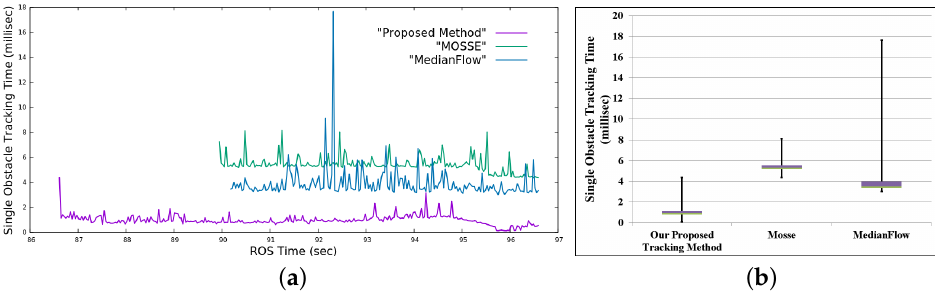
Figure 27. Comparison in execution time for single-obstacle tracking: ( a ) continuous running time and ( b ) the box